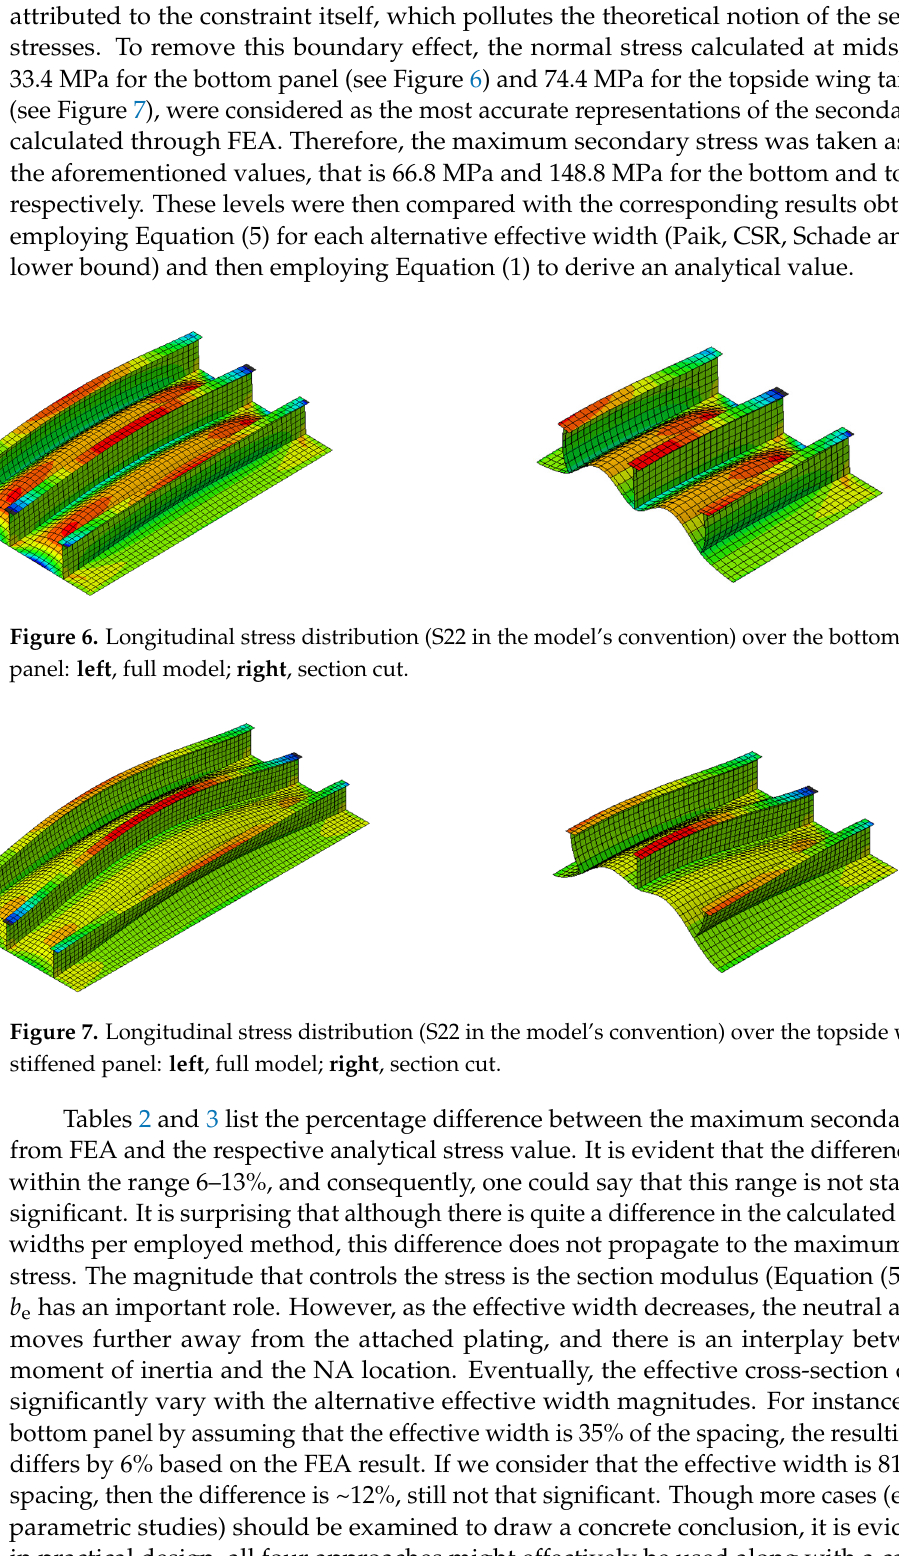
Table 2. Assessment of the effective width solution with respect to the FEA maximum normal stress for the panel taken from the bottom area of the ship. In Miller’s solution the out of parenthesis cor- responds at the uniaxial E* and within parenthesis at the biaxial E*.